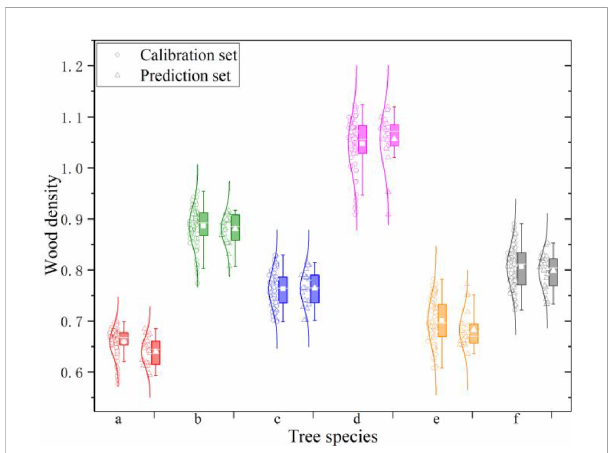
FIGURE 3 Statistical descriptive of wood density. (a – f) are Tilia tuan Szyszyl., Acer mono Maxim, Chinese white poplar (Jilin), Japanese elm, Chinese white poplar (Heilongjiang), and Dahurian larch,